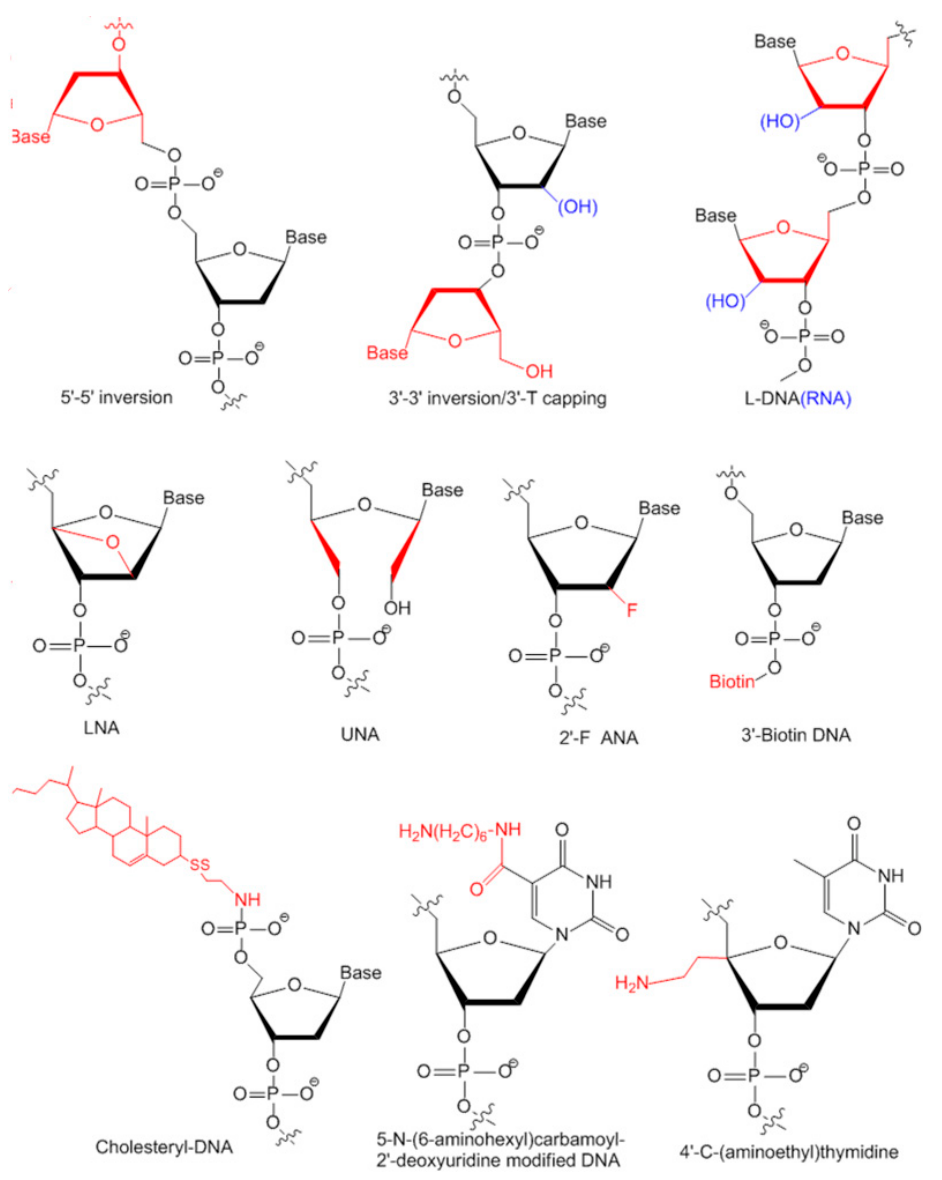
Figure 4. Various chemical modifications to stabilize aptamers (Adapted from Reference [30]). Modification sites are shown in red. The hydroxyl group of RNA is shown in blue to distinguish DNA and RNA.